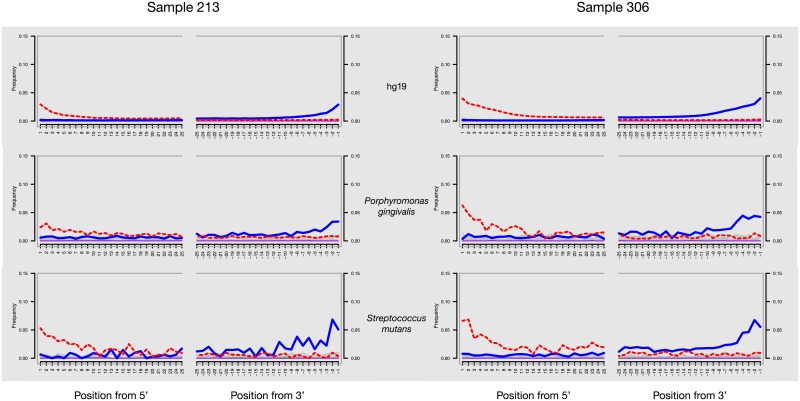
DNA damage patterns for teeth of subjects 213 and 306.The frequencies of all possible mismatches observed between the human nuclear genome (hg19), the P. gingivalis and S. mutans chromosomes and their mapped reads, respectively, are reported in gray according to the distance from 5’ end (left panel, first 25 nucleotides sequenced) and distance to 3’end (right panel, last 25 nucleotides sequenced). The typical DNA damage mutations C>T (5’) and G>A (3’) are reported in the dotted and solid lines, respectively.